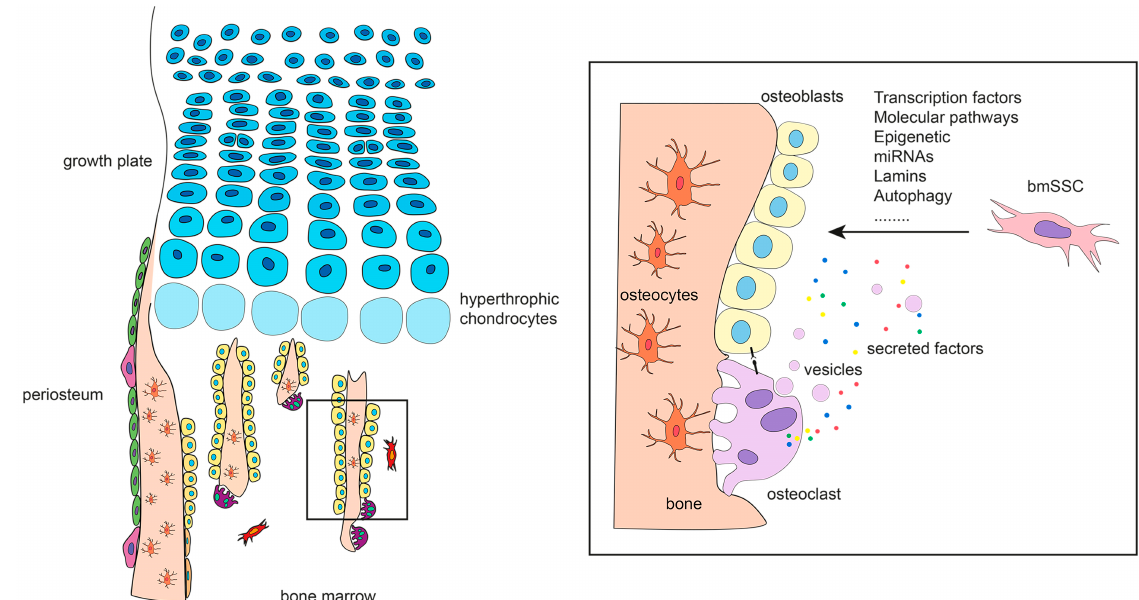
Figure 4. Left panel: Long bone skeletal compartments that host different subsets of stem/progenitor cells. Hypertrophic chondrocytes may also differentiate into bone forming cells. Right panel: Osteoclasts modulate osteogenic differentiation and osteoblast function by secreting regulatory factors and membrane-coated vesicles and by establishing cell–cell contacts with osteogenic cells.